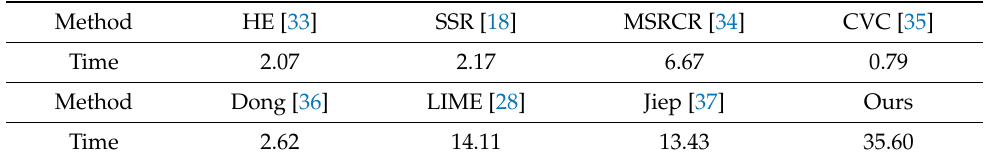
Table 2. Comparison of time cost (in